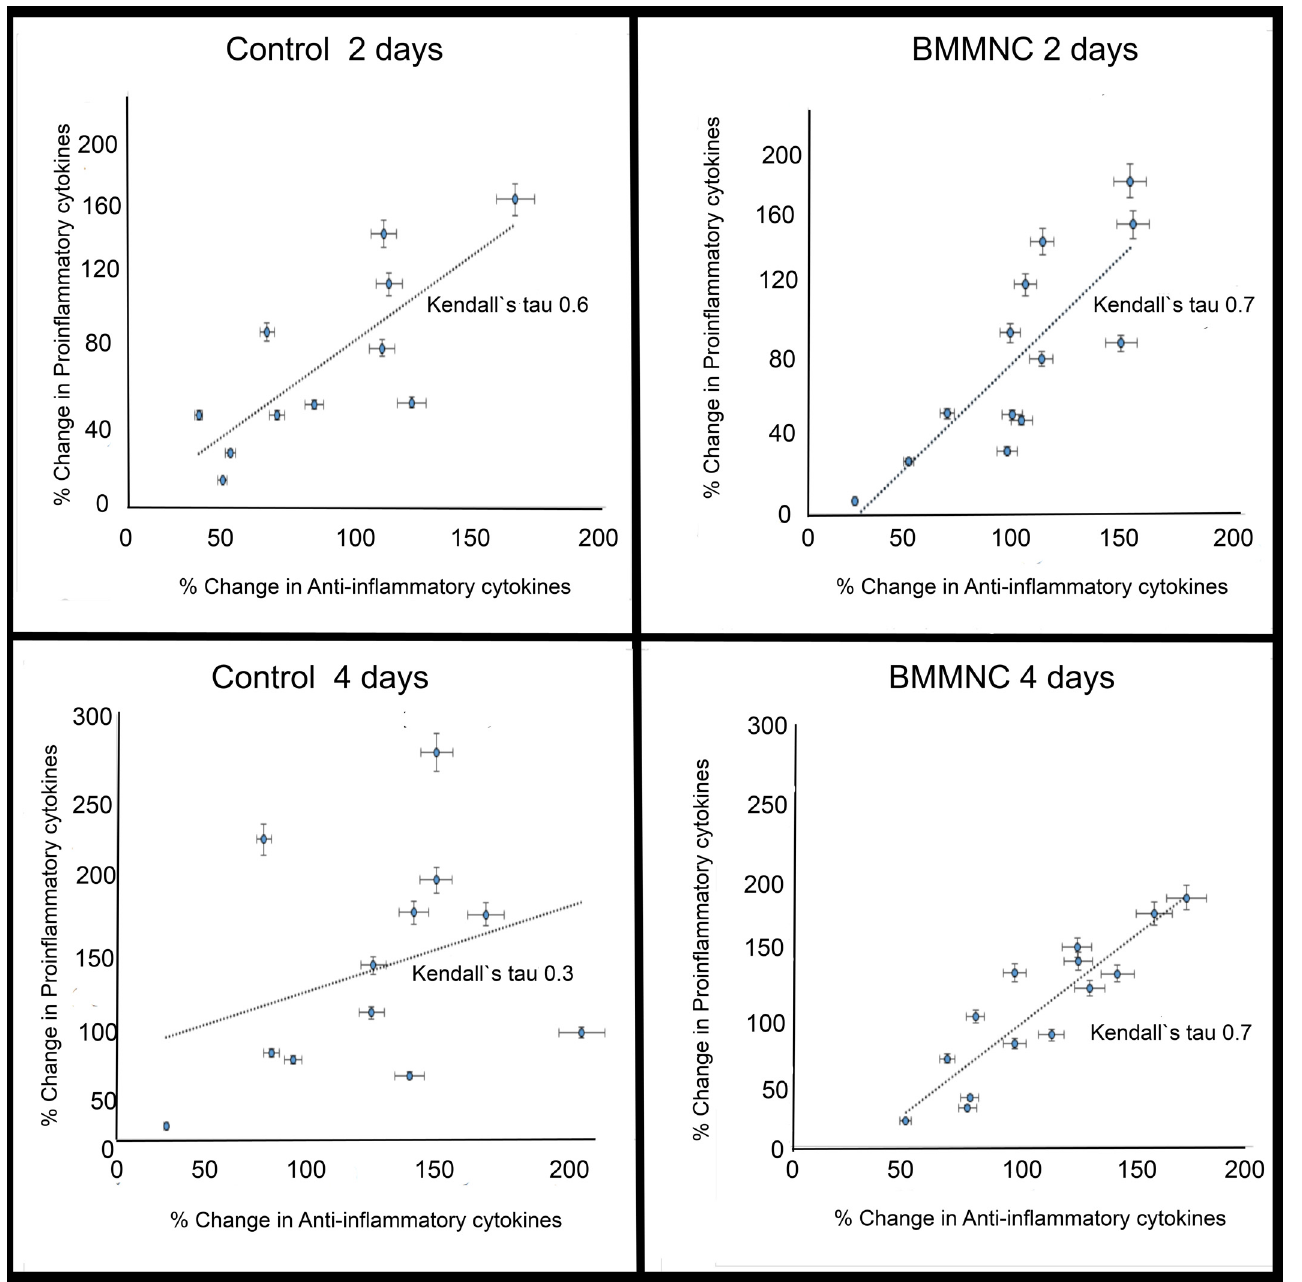
Fig 3. Balance in inflammatory cytokines. The percentage change of proinflammatory cytokines (IL-6, IL-1 β , IL-1ra, IFN- γ , TNF- α ) and anti-inflammatory cytokines (IL-4, IL-10, IL-13) was measured between time point baseline to 2 days and baseline to 4 days. Change in proinflammatory cytokines correlated with the change in anti-inflammatory cytokines in both study groups at 2 days. At 4 days, correlation remained only in BMMNC treated patients showing restored balance in inflammatory process.